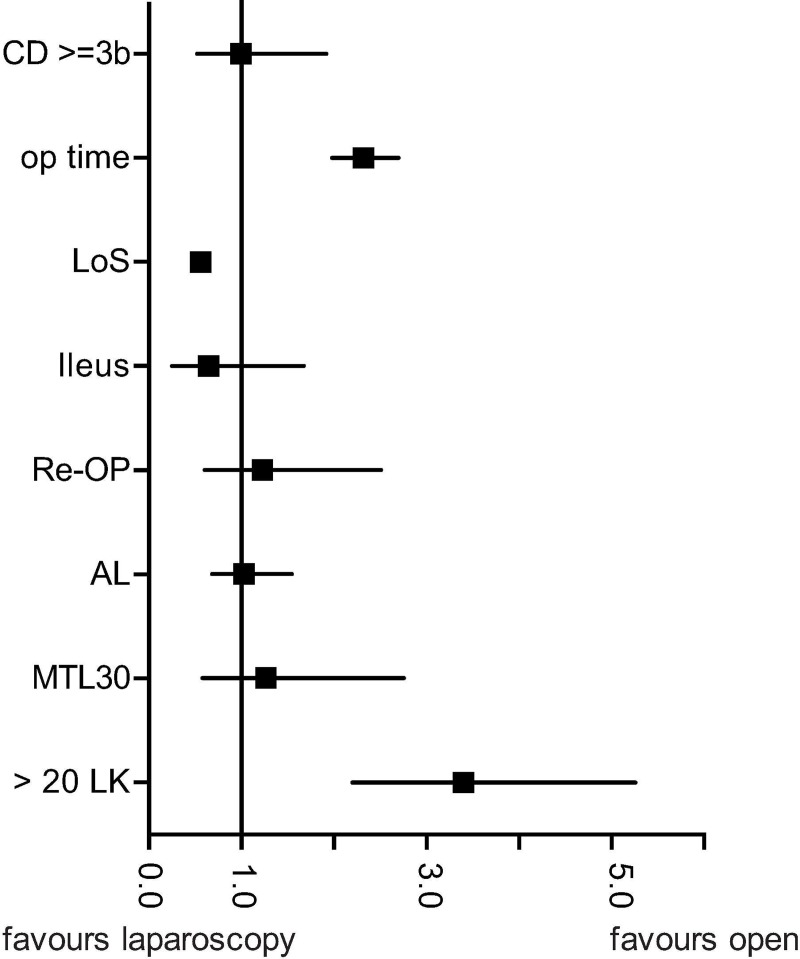
Adjusted odds ratios for outcomes by type of surgical approach.